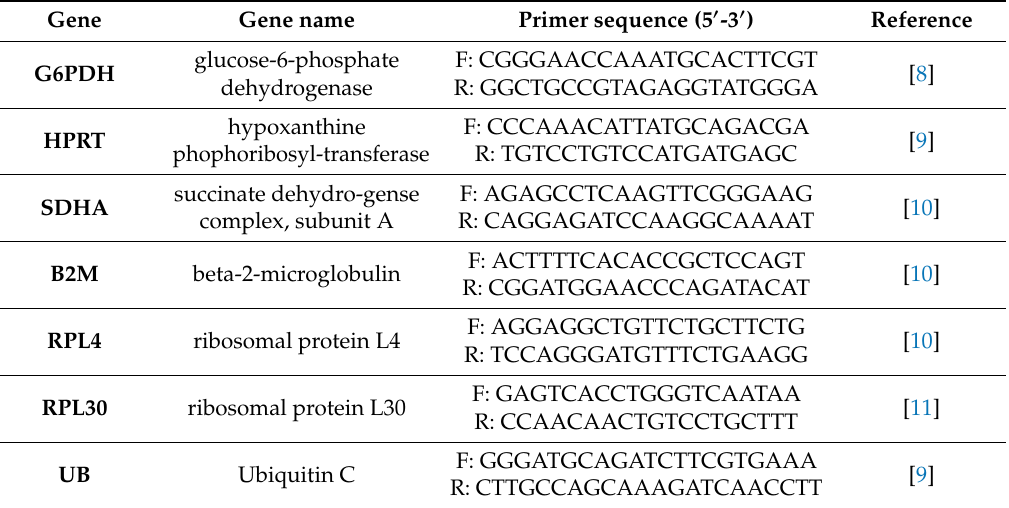
Table 1. Sequences of the reference gene